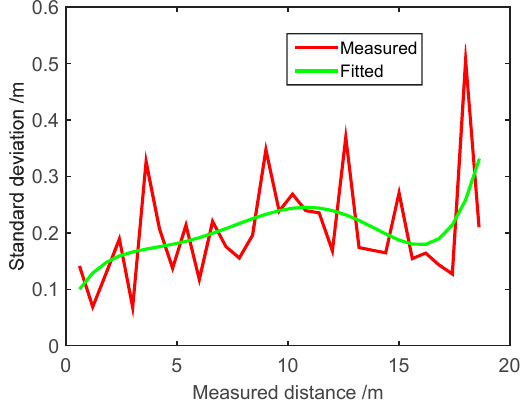
Figure 6. Standard deviation of measured distance for WSN.